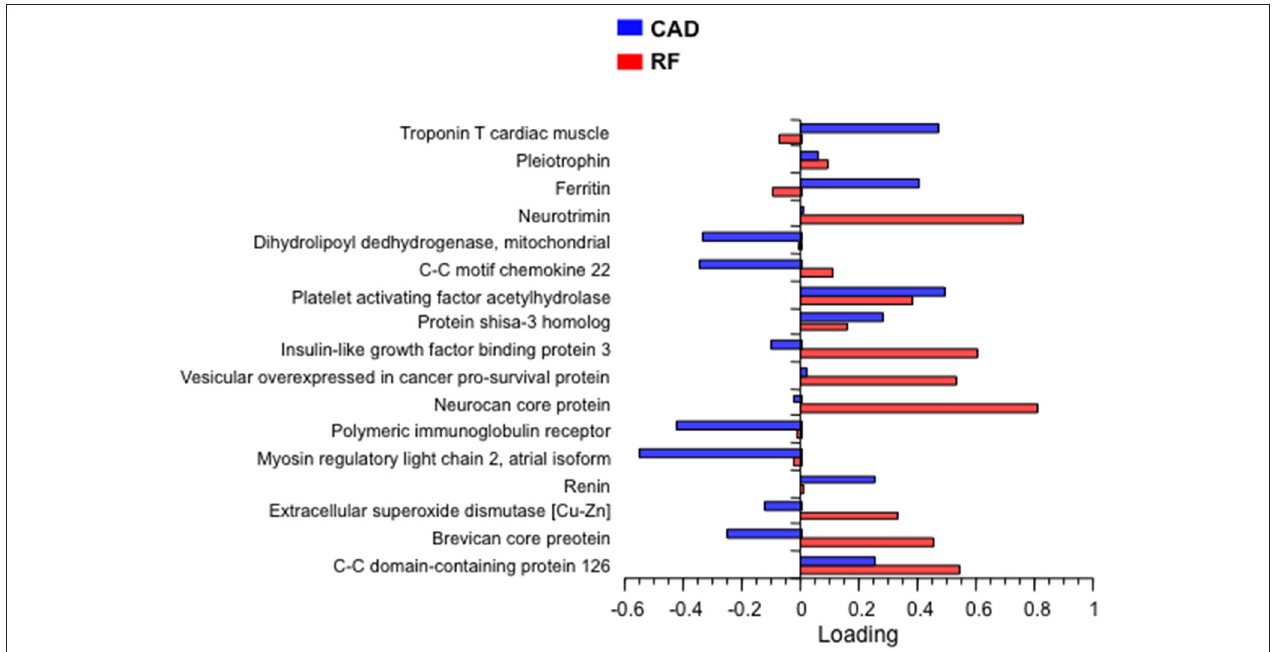
FIGURE 2 | Principal component loading of the 17 proteins in Table 3 on RFs and CAD. CAD, coronary artery disease; RF, risk factor. To quantify the unique association of each protein the other proteins and of gender, age and BMI, we